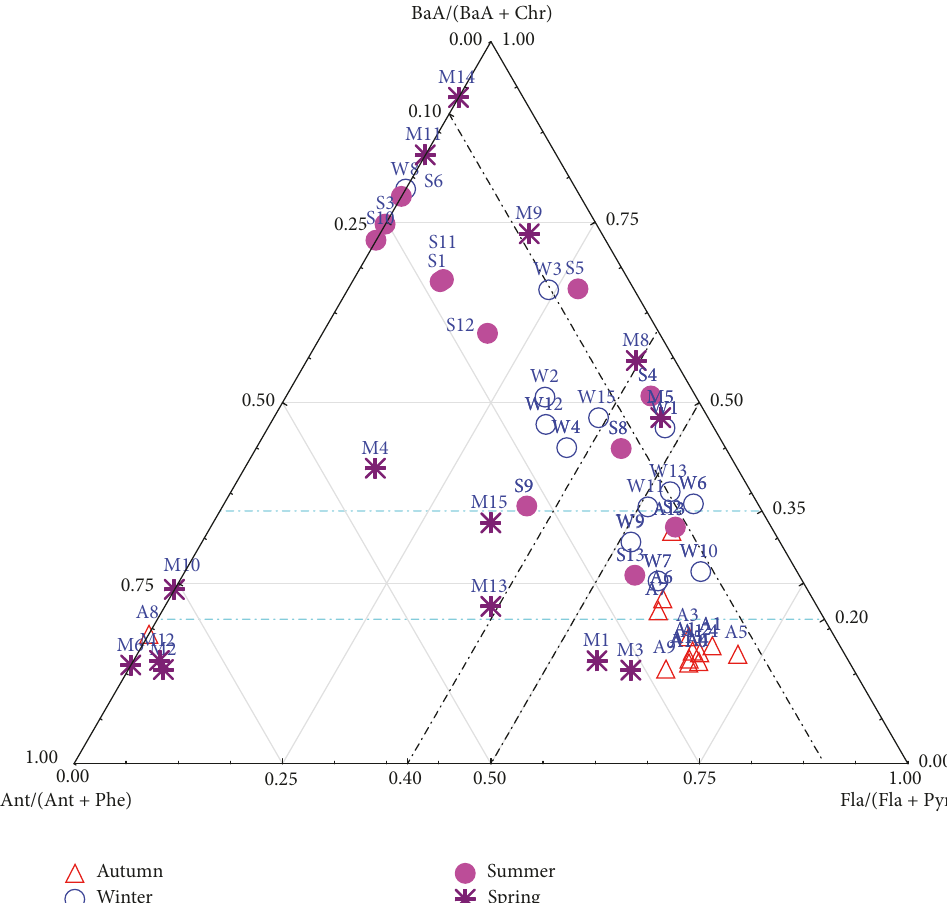
Figure 3: Plot of seasonal isomeric ratios Ant/(Ant + Phe) versus BaA/(BaA + Chr) versus Fla/(Fla + Pry). A: autumn, W: winter, S: spring, and M: